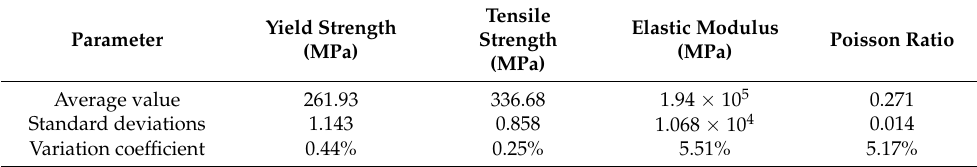
Table 1. Mechanical properties of the steel.